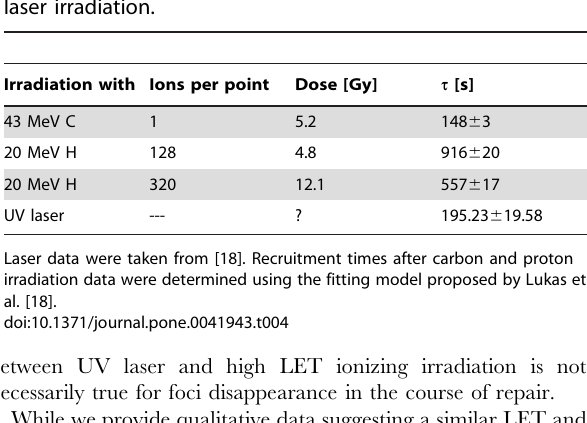
Table 4. Mdc1 kinetics after ion irradiation compared with UV laser irradiation.